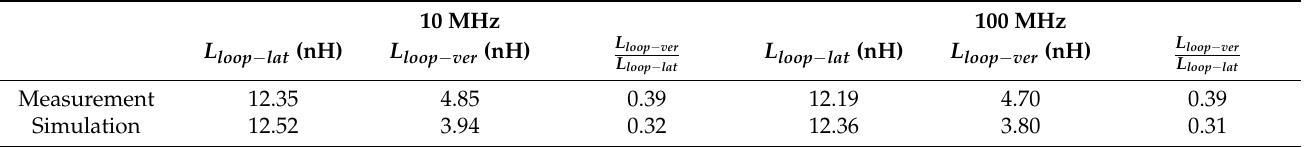
Table 2. Measured and simulated inductance values at 10 and 100 MHz for the different characterized loops. 10 MHz 100